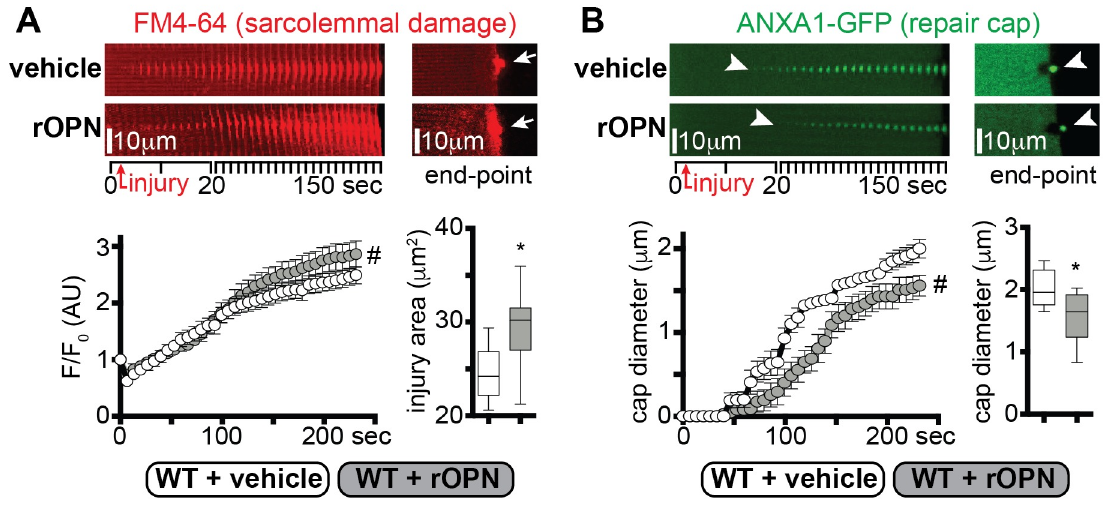
Fig 1. Excessosteopontin exacerbatessarcolemmal injury and delays repair cap formation. The sarcolemmalwounding assay was performed on flexor digitorusbrevis muscles from WT muscle in the presenceor absence of recombinantosteopontin (rOPN; 10 μ lat 1 μ g/ μ l). A) The extent of sarcolemmal damage,monitoredas FM4-64 area, was greater in rOPN-treated myofibers comparedto vehicle-treated control, both over time and at end-point(arrows). B) Repair cap formation, monitoredby GFP-tagged annexinA1 (GFP-ANXA1) was delayedin rOPN-treated myofibers (arrowheads). Repair cap diameter at end-point was smaller in treated comparedto control myofibers (arrowheads). Over time image series represents stacked consecutive images of the injuredsite at 10˚ orientationto reveal the extent of dye accumulationor repair cap formation (S1B Fig). FM4-64 and ANXA1-GFP pictures were acquiredsimultaneously. Marked line plots, avg ± sem; box plots, Tukey distribution; n = 50 myofibers (5 mice)/group; #, P < 0.05vs vehicle, 2way ANOVA + Bonferroni; * , P < 0.05 vs vehicle, unpairedt-test with Welch’s